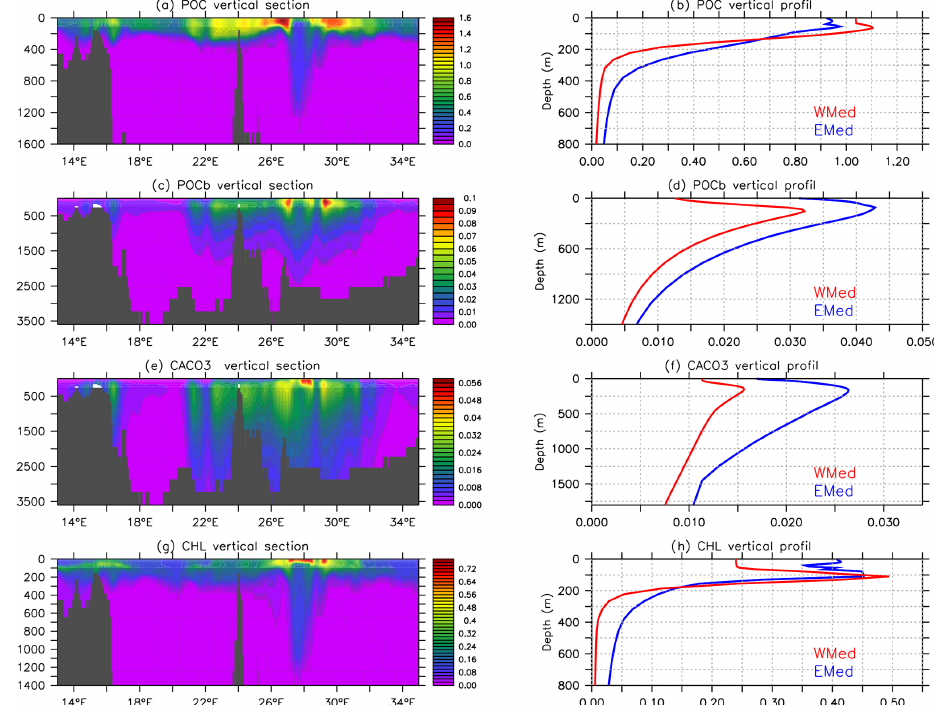
Figure A5. E–W vertical section in the eastern Mediterranean basin (left panel) and comparison of average vertical profiles (right panel) for monthly mean climatological values of POC s (small organic carbon concentration), POC b (big organic carbon concentration), CaCO 3 (calcite concentration), and CHL (total chlorophyll) for the western basin (red line) and eastern basin (blue line) in µmolL − 1 .